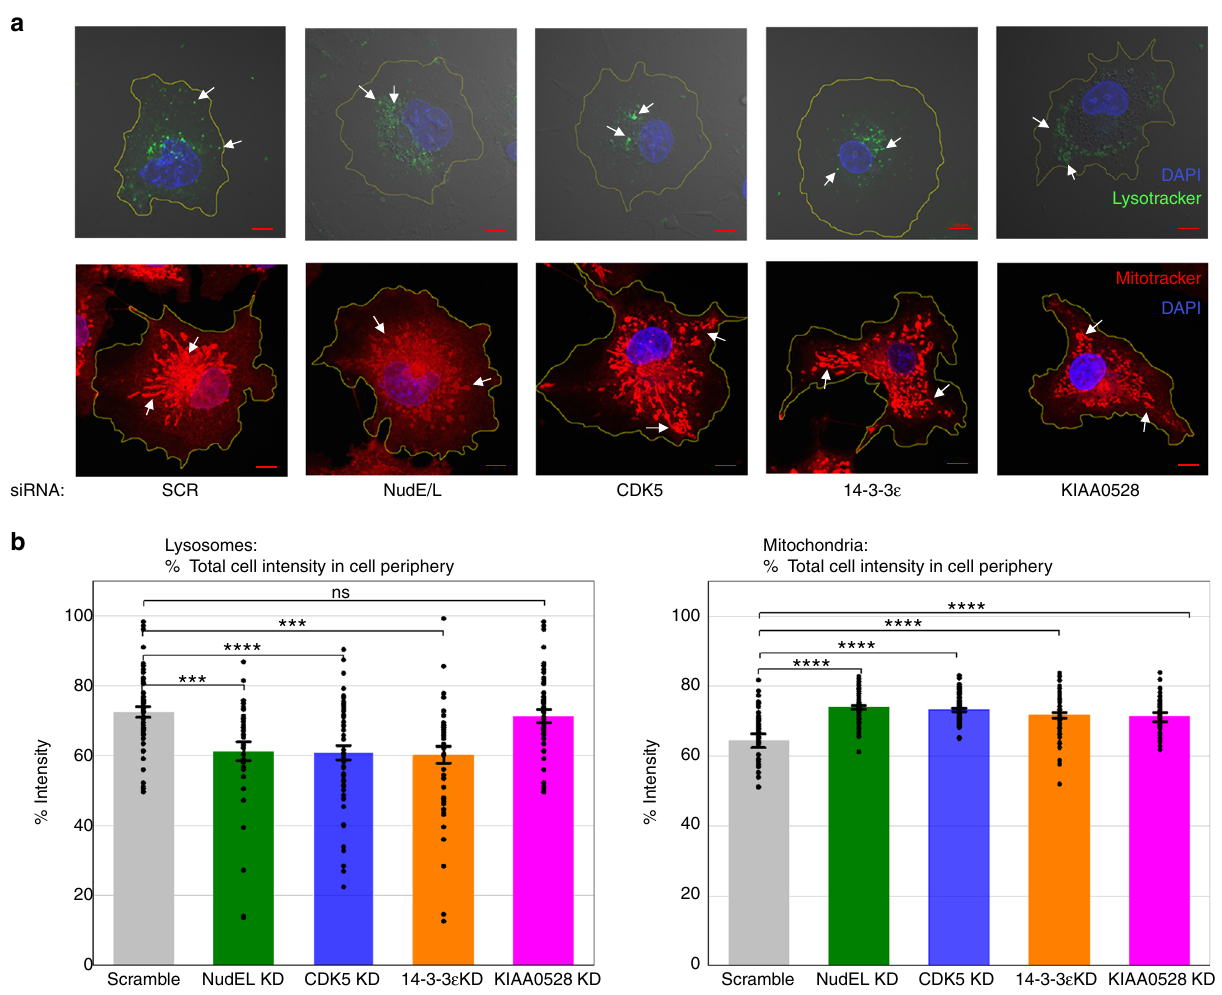
Fig. 7 CDK5-activated dynein affects lysosome and mitochondria distribution in live cells. Representative images of cells in various backgrounds stained with DAPI and either LysoTracker-Yellow or MitoTracker-Red with 10 μ m scale bars and white arrows to point out example lysosomes and mitochondria ( a ) and quanti fi cation of lysosome or mitochondria distribution ( b ). Quanti fi ed data represent the mean ± s.e.m. of n = 2 independent experiments. Test of proportions P values *** P < 0.001, **** P <